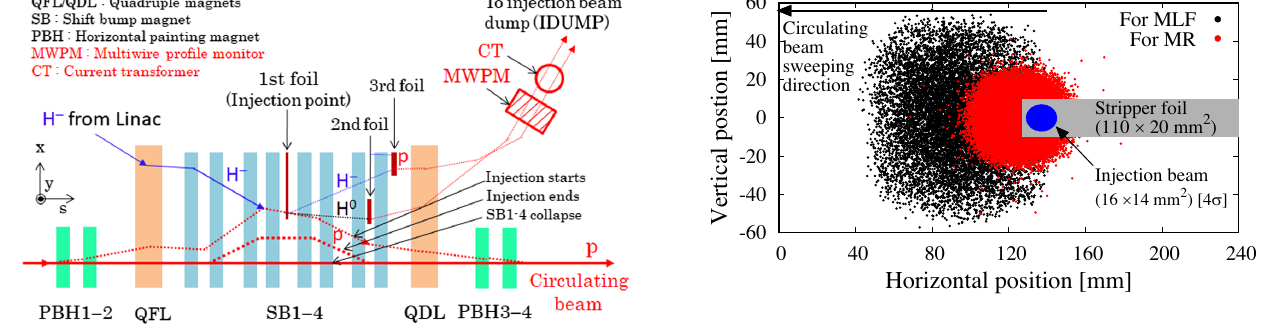
FIG. 2. A schematic view of the RCS injection area, location of stripper foils, and their roles. 99.7% of the H − is stripped to p by the first foil and injected into the RCS. The partially stripped H 0 and unstripped H − are further stripped to p by the second and third foils, respectively, and directed to the IDUMP.